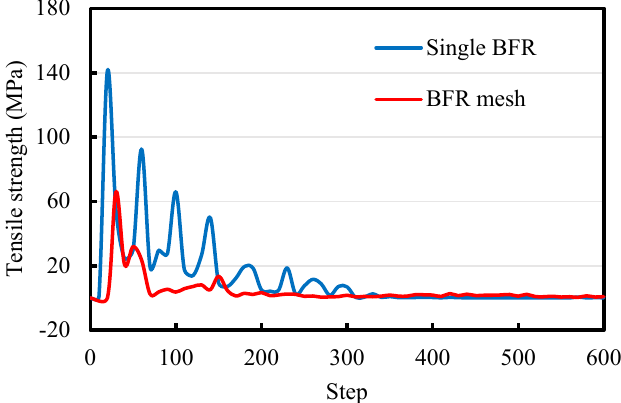
Figure 6. Stress curves simulated by PFC3D.